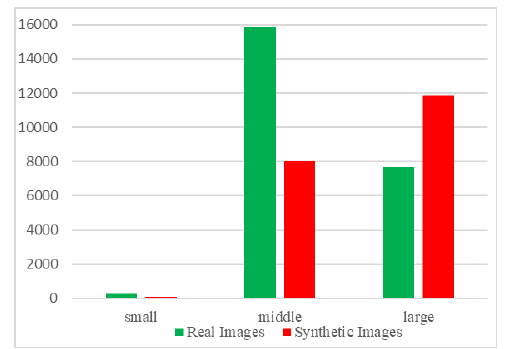
Figure 7. Size Distribution of Training Data. Small, middle, large refers objects whose size are smaller than 32 2 pixels, between 32 2 and 96 2 pixels, and larger than 962 pixels respectively.